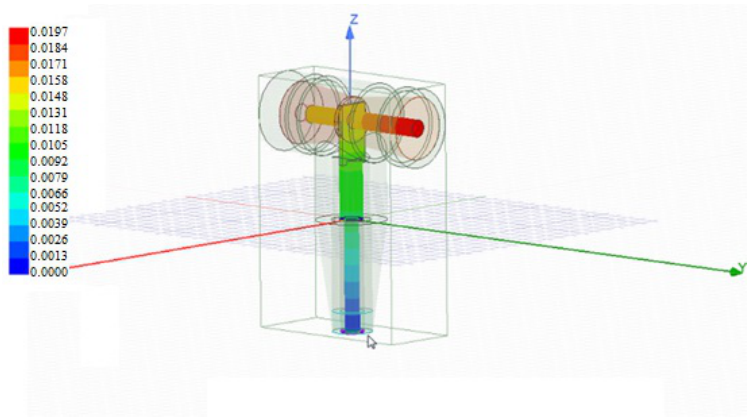
Figure 7. The voltage level of the conductive elements, I = 630 A.